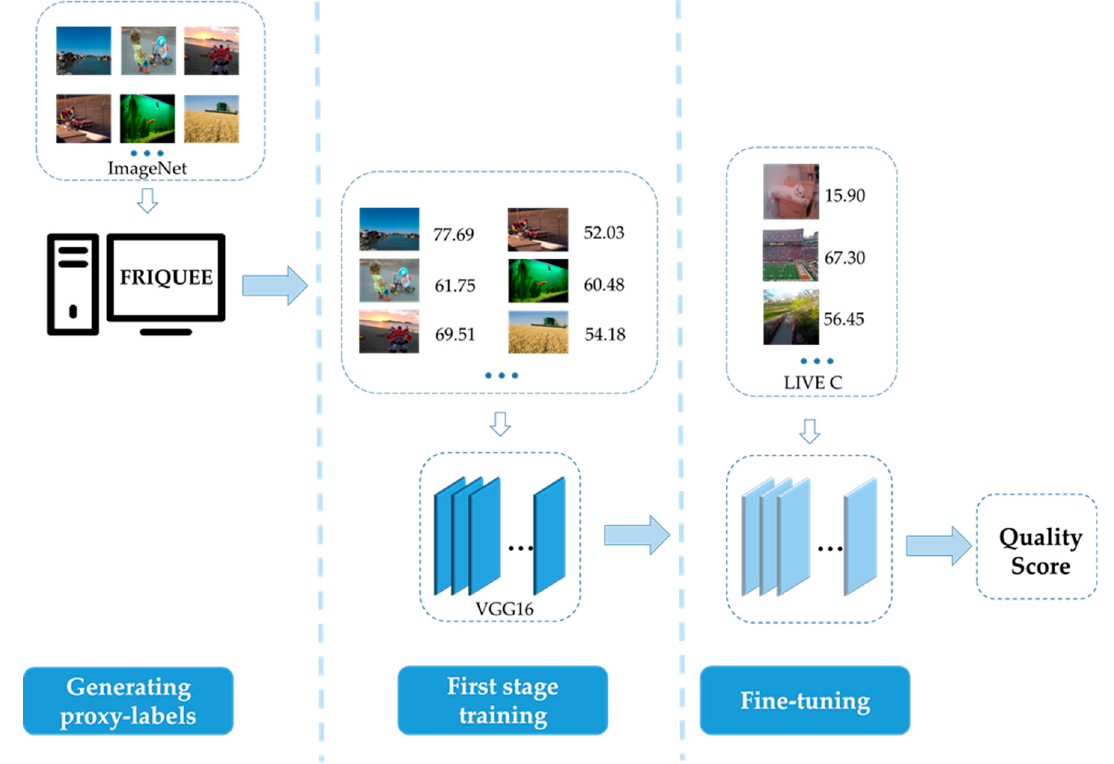
Figure 1. A flowchart of the expanding the proxy labels algorithm (EPL). (1) Generate large number of proxy labels attached to the image in ImageNet [14], using the FRIQUEE algorithm; (2) train VGG16 using the proxy label; (3) fine-tune the model using IQA data, in our method is LIVE In the Wild Image Quality Challenge database [15]. Ultimately, the model can assess the image quality and score images. In the first stage training, the values next to the images are the proxy labels generated by the computer. As for the fine-tuning stage, the values are the quality score given by observers in LIVE In the Wild Image Quality Challenge database [15].